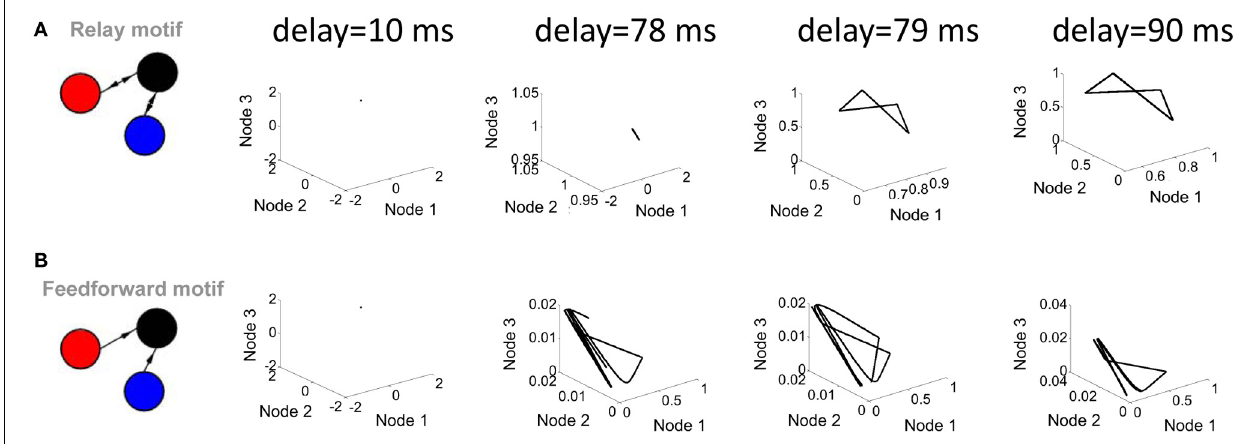
FIGURE 3 | Influence of transmission delay on network activity. ( A ; left panel) Illustration of a relay network with both feedforward and feedback connections. (right panel) Phase-plane plots of activity simulated with a